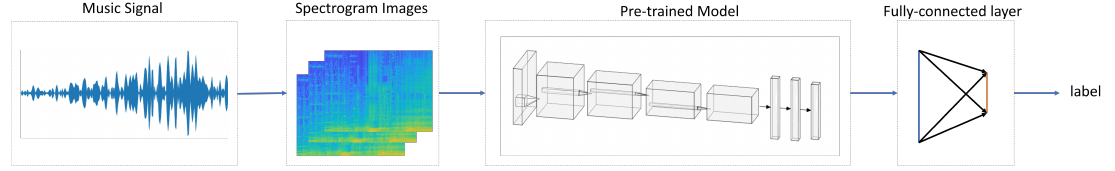
Figure 4. The flow chart of the overall deep learning